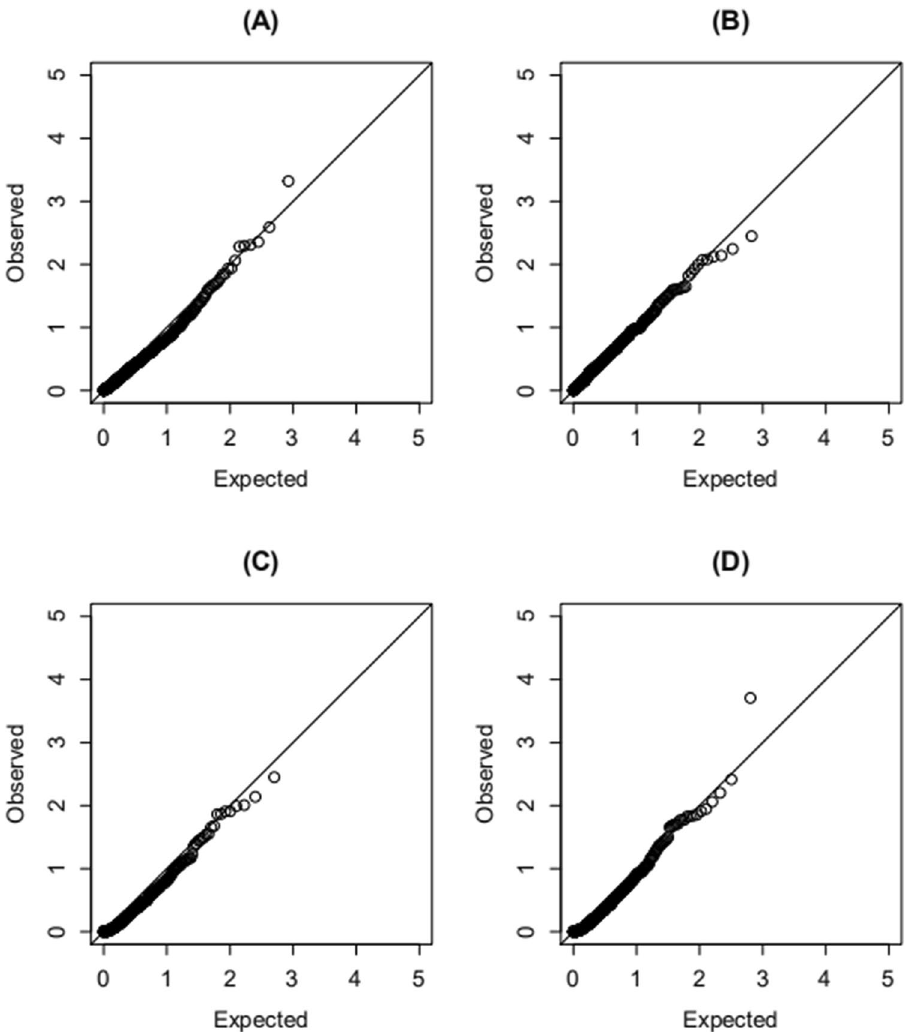
Figure 1. Q–Q plots of the null distributions in the test for SNP-environment interaction effects and the joint test for SNP and SNP-environment interaction effects. ( A , B ) The tests for SNP-environment interaction effects with 100 and 400 overlapping individuals between any two studies. ( C , D ) The joint tests for SNP and SNP- environment interaction effects with 100 and 400 overlapping individuals between any two studies. The vertical axis is the—log10 (observed P value) from data analyzed under the null hypothesis, and the horizontal axis is the—log10 (expected P